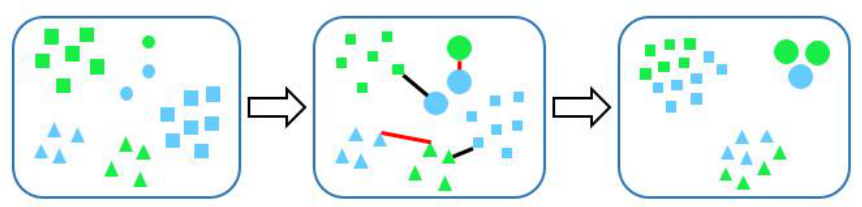
Figure 2. The green and blue indicate two kinds of feature spaces. Then we employ weighted pairwise constraints to the feature spaces. Here, red and black lines denote similar pairs and dissimilar pairs, respectively. The final feature space is learned for cloud